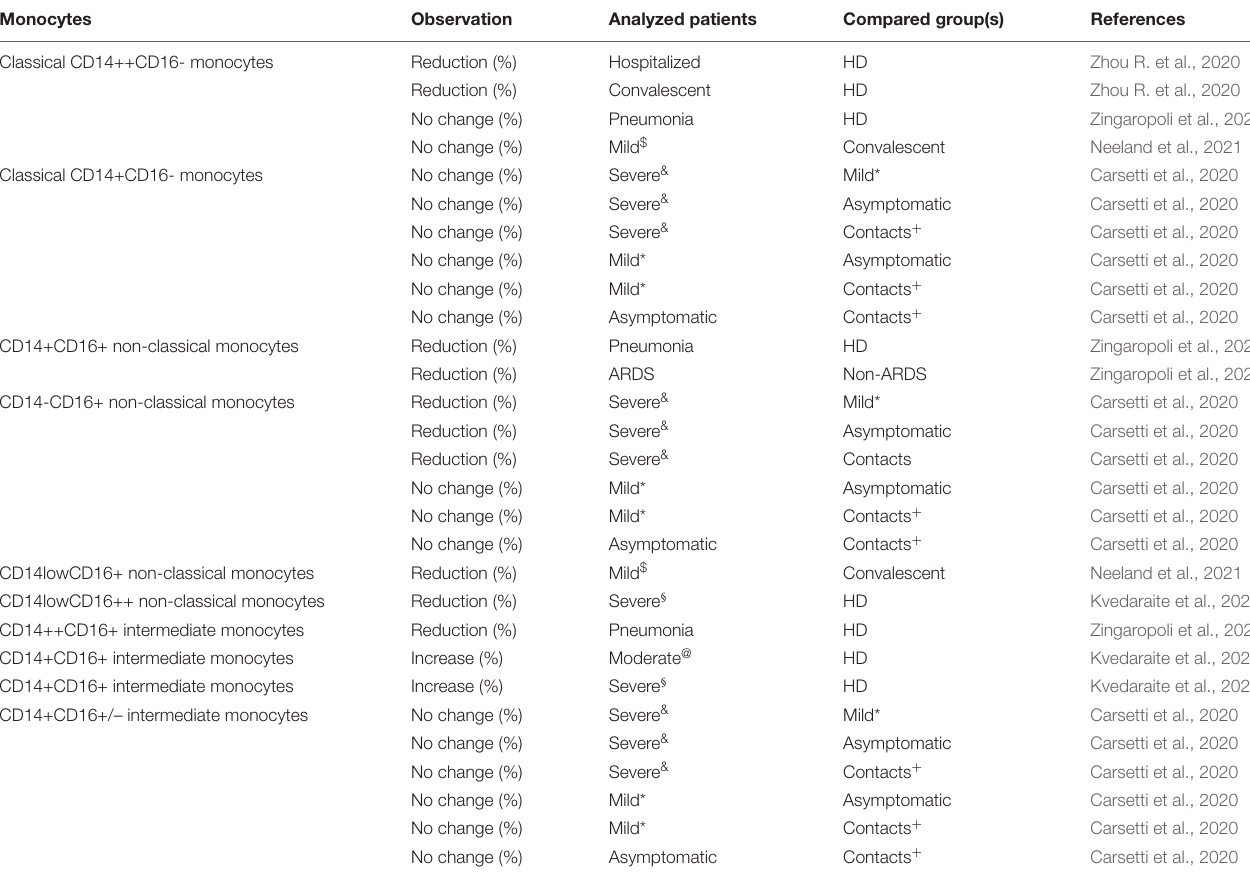
TABLE 3 | Observed fluctuation in monocytic subsets in adult COVID-19